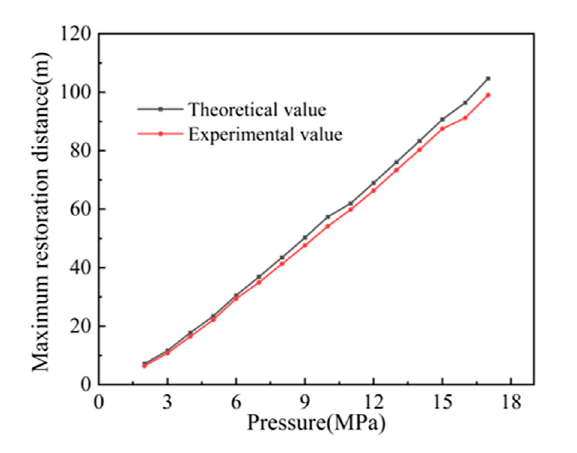
FIGURE 10 Variation of k at different speeds of motion.